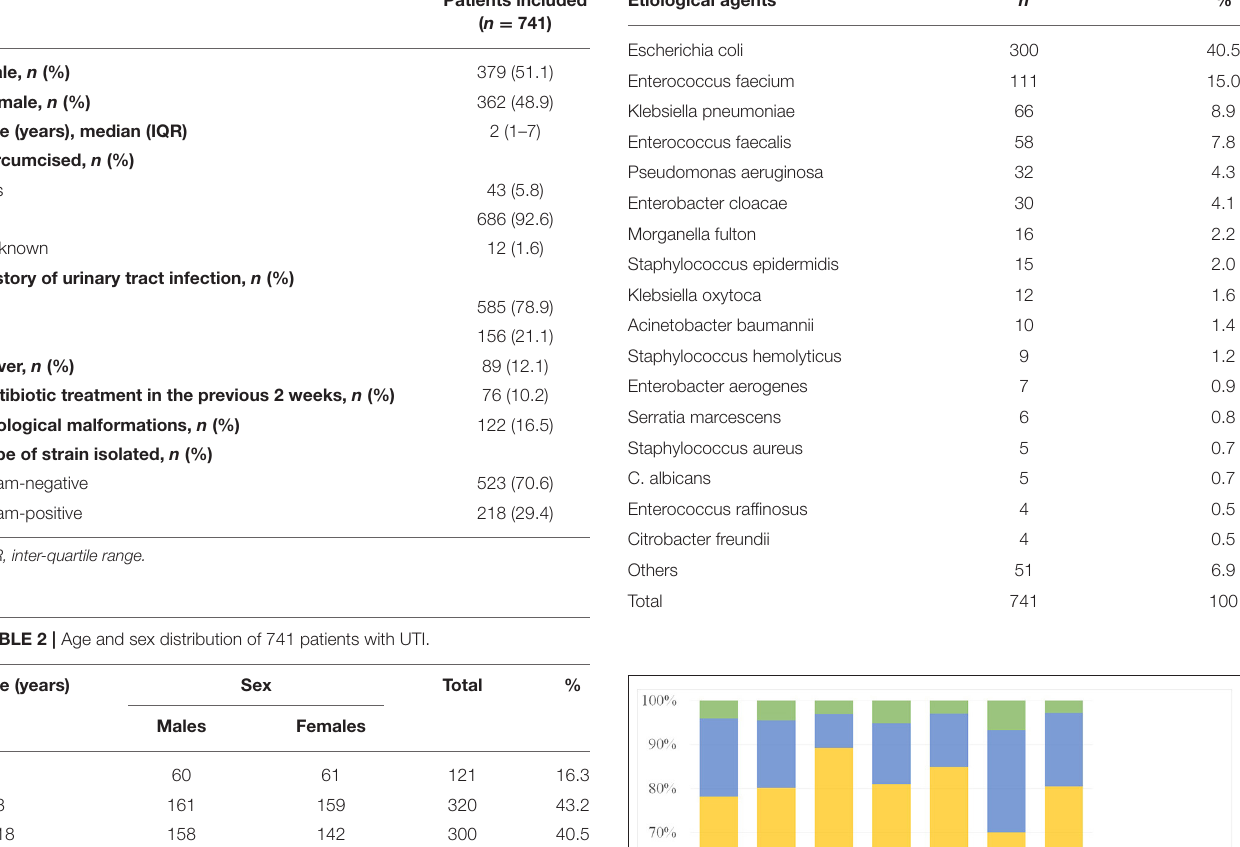
TABLE 3 | Etiological agents in children with urinary tract infection.